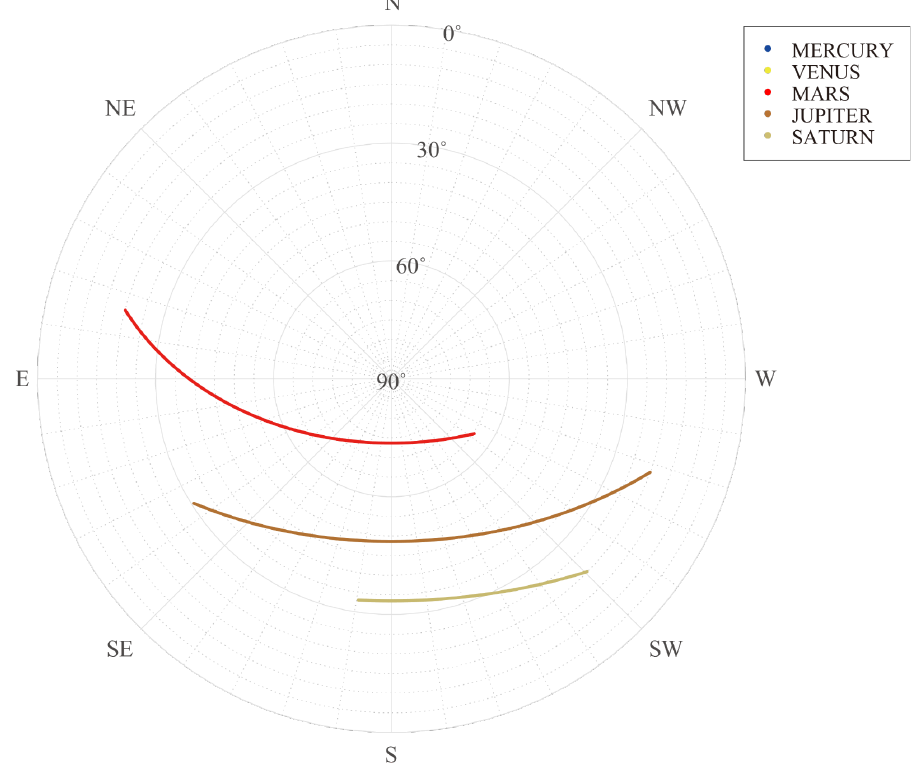
Figure 8. Observable altitude and azimuth positions of targets in the local virtual ground-based observatory (VGO) coordinate system at corresponding observation window (OBW) on 26 October 2022. Table 4. Recommended schedule generated by the AST for VGO on 26 October 2022.